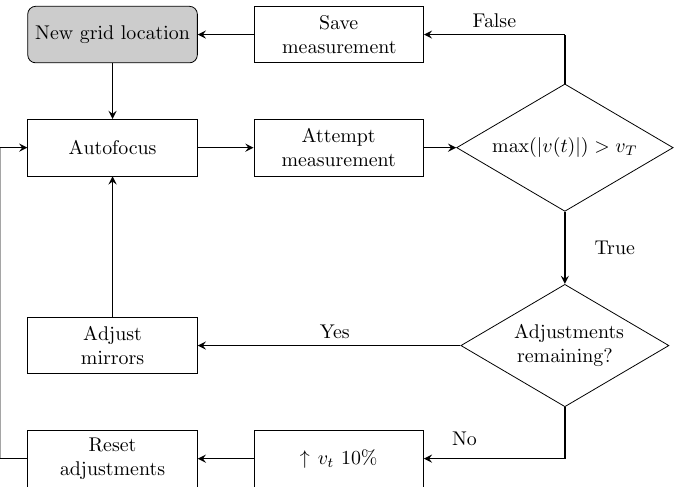
Figure 3. The measurement procedure where t is time, v ( t ) is the LDV measurement and v T is the Figure 2: Flow chart of the measurement process where v is the LDV time mea- surement and v t is the threshold velocity within the measurement. Adjustments threshold velocity, initially set to twice the root mean square of the first object occur in the order of